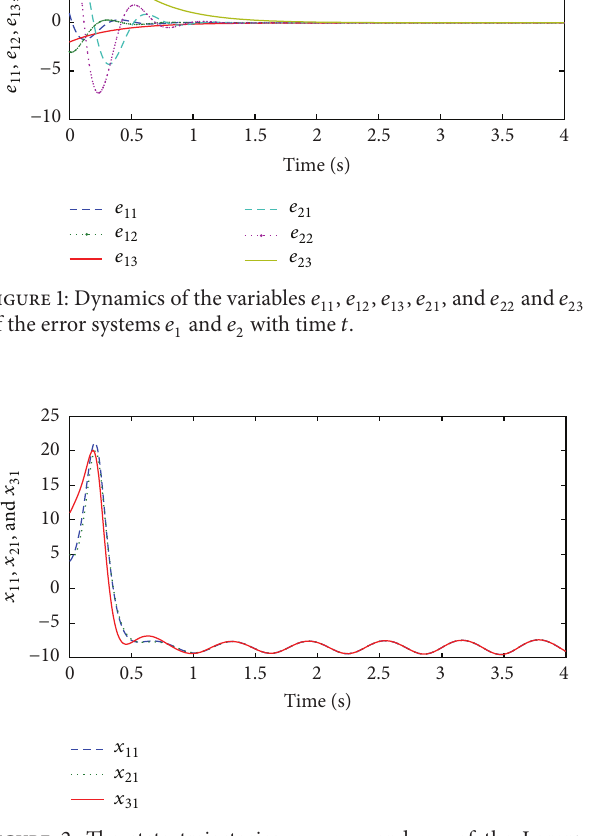
Figure 2: The state trajectories 𝑥 11 , 𝑥 21 , and 𝑥 31 of the Lorenz systems with time 𝑡